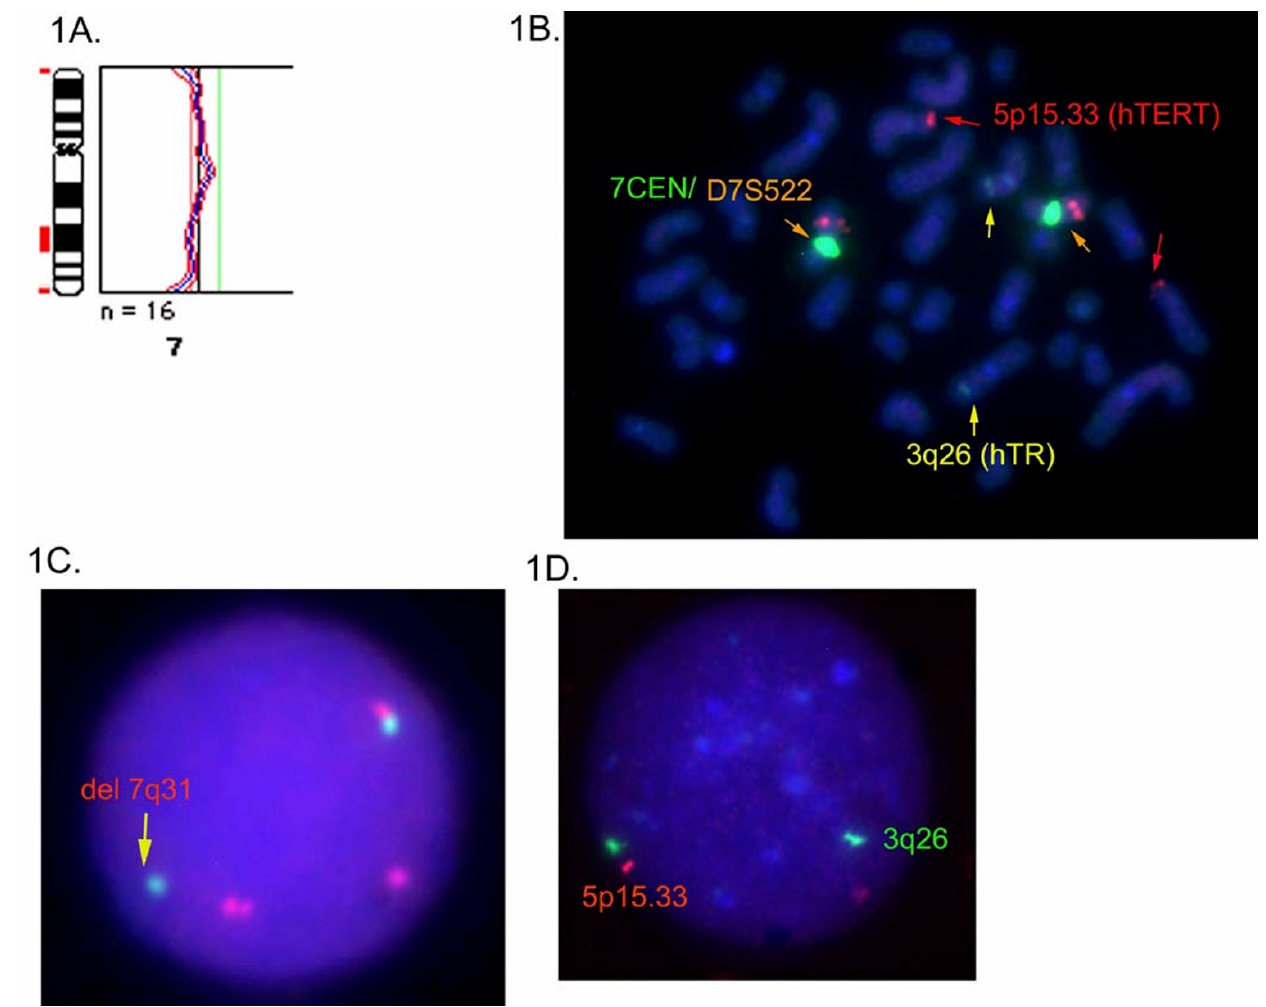
Figure 1 CGH analysis of chromosome 7 in the 7q- samples and FISH analysis of the relevant regions on chromosomes 3, 5 and 7. A. CGH analysis of pooled DNA from the 7q- samples hybridized against control DNA from a normal male donor. The CGH profile for chromosome 7 is shown. A deletion is seen in the 7q31 region as indicated on the idiogram. B. Triple color hybridi- zation for 7CEN/D7S522, hTERT, and hTR. 7CEN (orange arrows) and hTR (yellow arrows) appear in green. In the micro- scope the hTR signal was bright and clearly visible, but in the present representation it appears weak due to the auto exposure in the green channel being governed by the stronger 7CEN signal (compare with panel D). Both D7S522 (orange arrows) and hTERT (red arrows) appear red in this representation. In the microscope, each of the two probes appeared in its recognizable reddish color, but the difference could not be reproduced here. C. Dual color hybridization of hTERT (red) and chromosome 7 probes (green centromere juxtapositioned with red 7S522). While both hTERT loci are labeled, one chromosome 7 has only a centromere signal, and not a 7q31 signal. D. Dual color hybridization of the hTR and hTERT probes showing two signals for each probe. This was the general finding in all 65 samples. In the absence of the green centromere 7 signal the hTR probe is clearly visible after auto